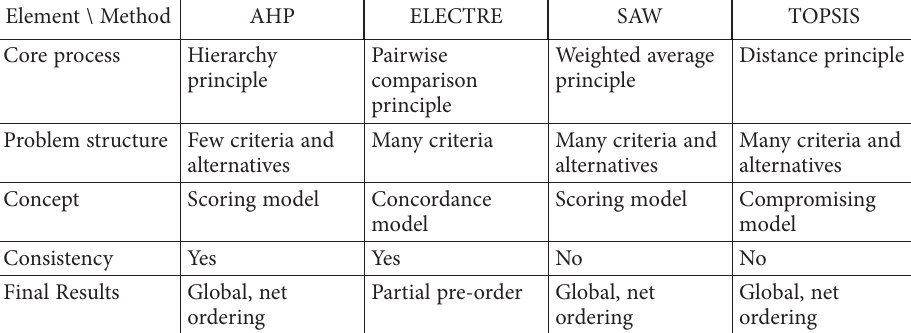
Table 1A. Comparison of AHP, ELECTRE, SAW and TOPSIS according to Thor et al. (2013) Element \ Method AHP ELECTRE SAW TOPSIS Core process Hierarchy Pairwise Weighted average Distance principle principle comparison principle principle Problem structure Few criteria and Many criteria Many criteria and Many criteria and alternatives alternatives alternatives Concept Scoring model Concordance Scoring model